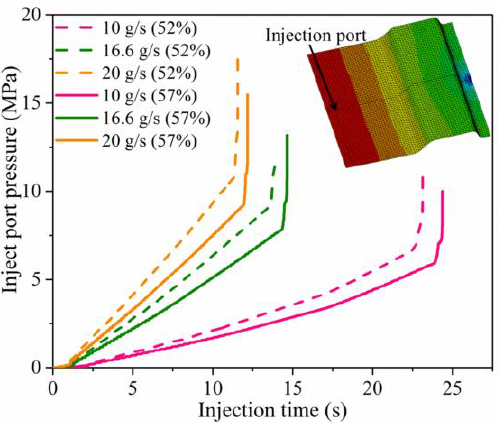
Figure 5. Inject port pressure against injection time curves for HP-RTM simulation.